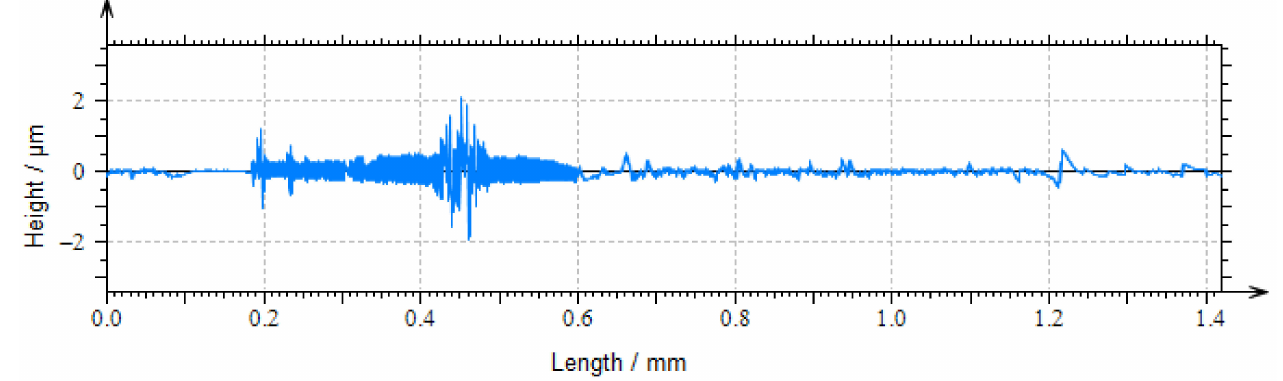
Figure 17. Circular ripples on the tip of the diamond